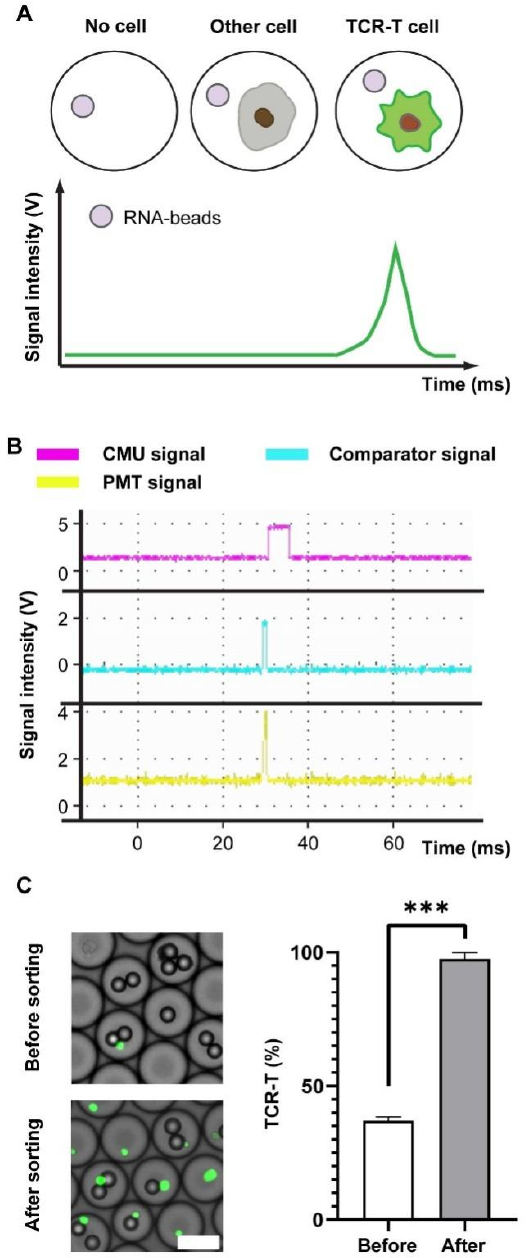
Figure 2. Droplets sorting and signal analysis. ( A ) The signaling patterns of droplets with cell-free, off-target-cell, or TCR-T cell. ( B ) A signal recording of droplets with TCR-T cell and feedback signals from comparator and CMU against a positive droplet. ( C ) Images of droplets before and after sorting (left) and the percentage of CMFDA+ cells detected by flow cytometric analysis. The TCR-T cells are highlighted by green points. Scale bar: 50 µ m. Wilcoxon test is used, and *** p < 0.001. *** represents a significant difference.